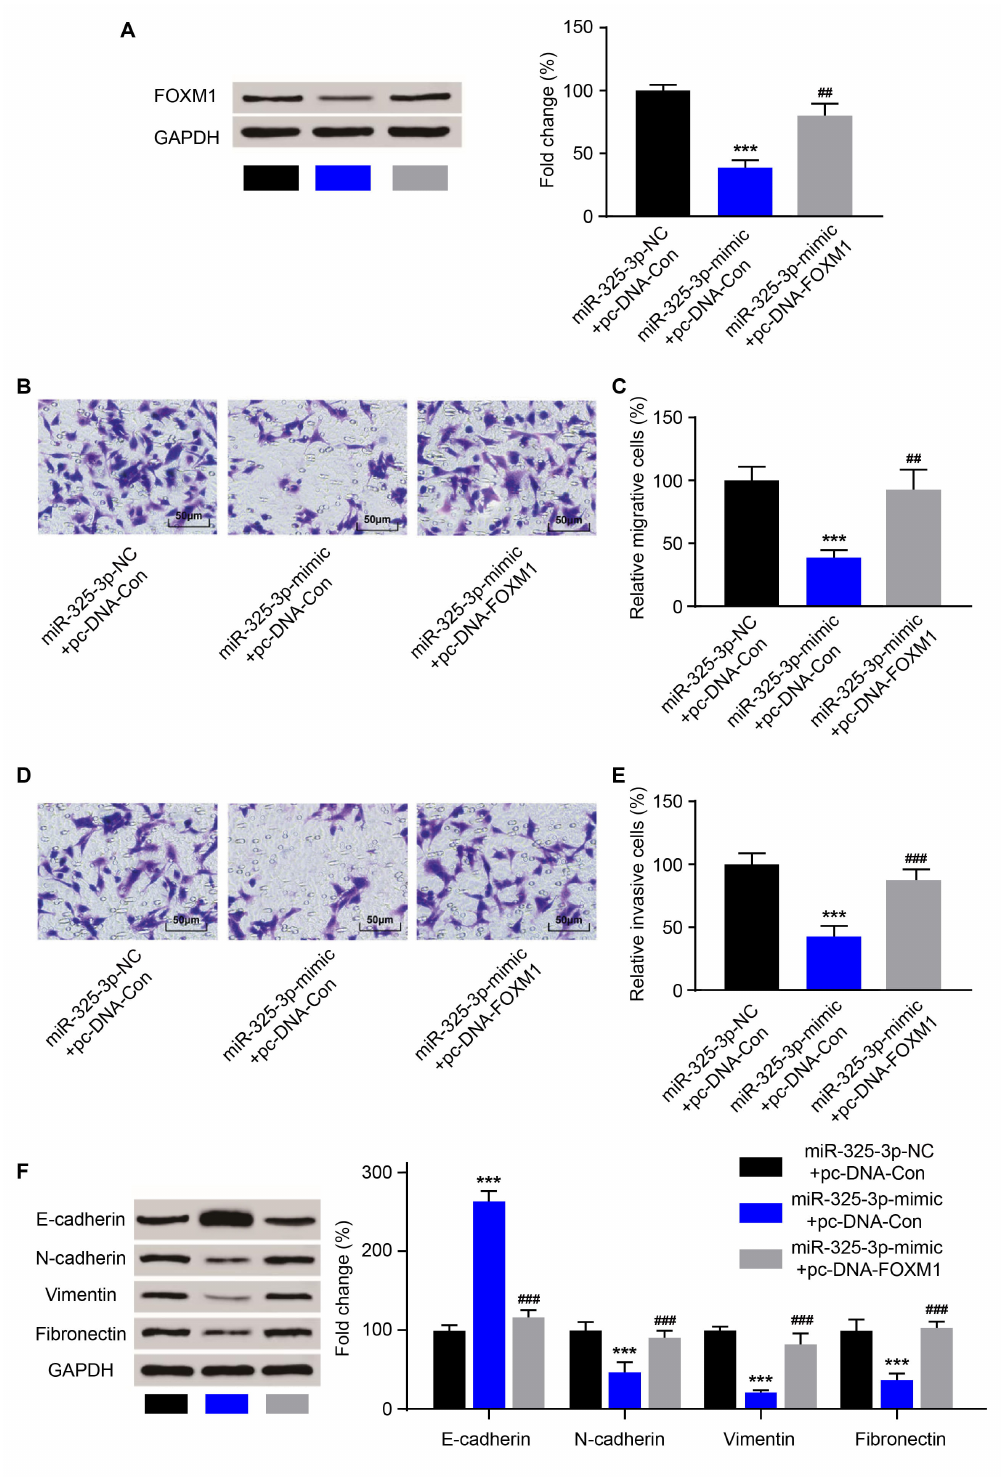
Fig.6. MiR-325-3pregulatesmigrationandinvasioninU87cellsbytargetingFOXM1expression. (A) Western blot analysis showed that upregulation of miR-325-3p decreased the expression of FOXM1, and this effect was reversed by transfection with pcDNA3.0-FOXM1 in U87 cells. (B–E) Functional rescue experiments with Transwell assays showed that pcDNA3.0-FOXM1 transfection restored the migration and invasion abilities of U87 cells transfected with miR-325-3p-mimic. (F) The expressions of EMT-related genes were detected after FOXM1 was overexpressed in U87 cells via western blot. Data are presented as the mean ± SEM, *** p < 0.001, compared to the miR-325-3p-NC + pcDNA-Con group; ## p < 0.01, ### p < 0.001, compared to the miR-325- 3p-mimic + pcDNA-FOXM1